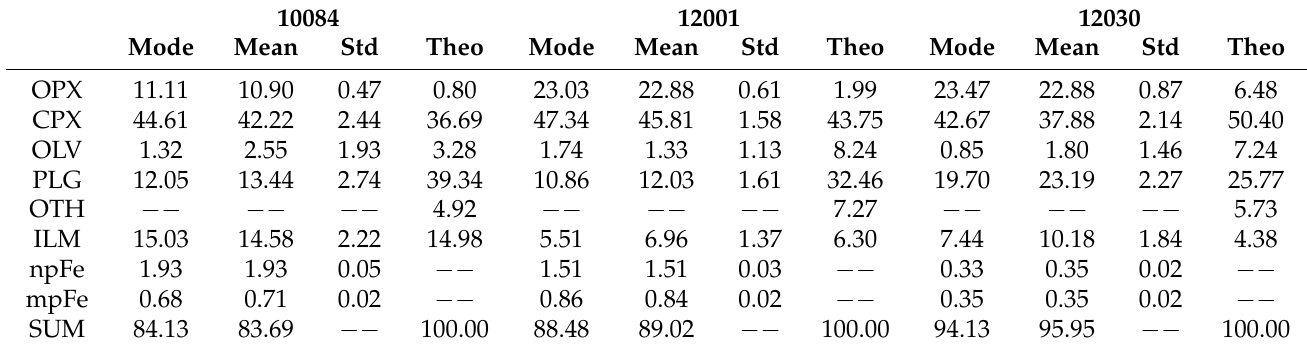
Table A11. Detailed results for the unmixing of LSCC spectra with the catalog of RELAB endmembers. For all relevant elemental abundances a prior was